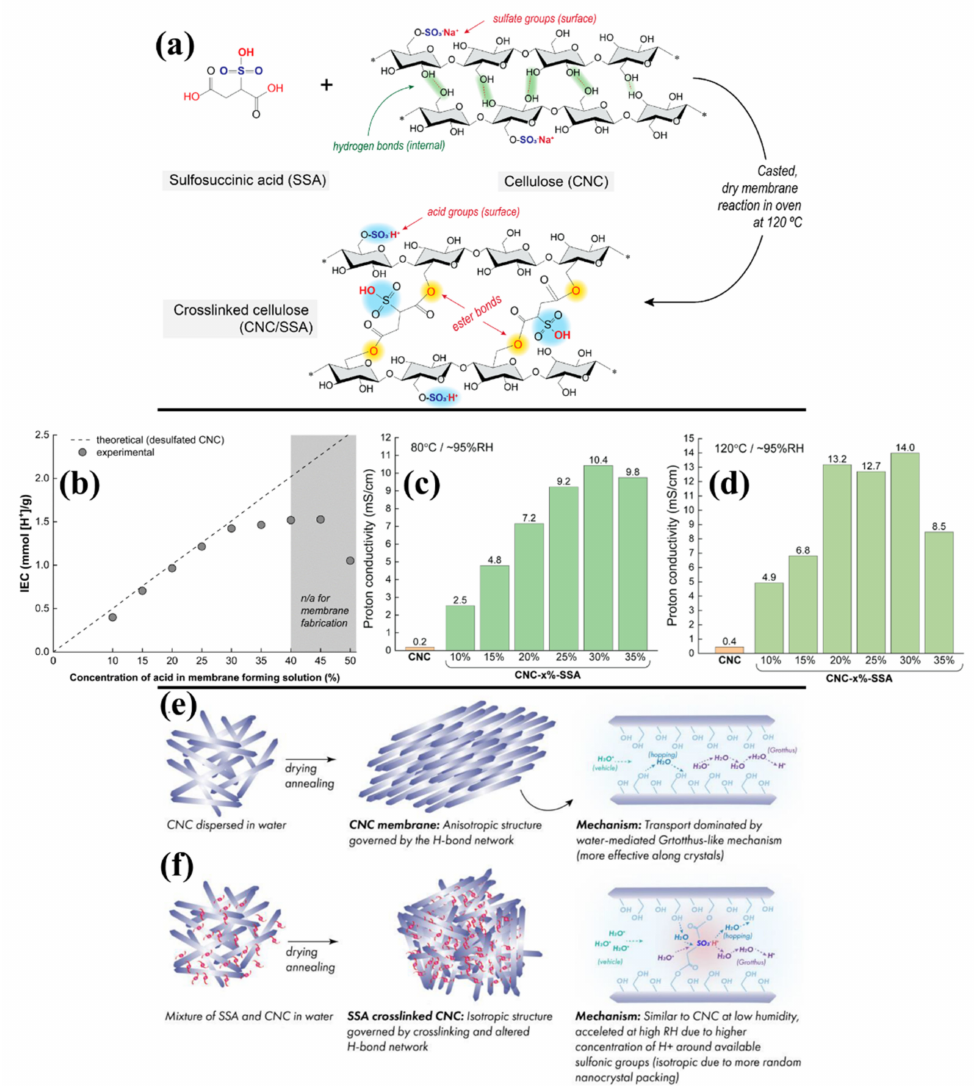
Figure 4. ( a ) An illustration of the cross-linking reaction between sulfosuccinic acid and CNCs, and ( b ) IEC of the CNC − SSA (with different concentrations). Proton conductivity measurement results of different ratios of CNC − SSA membranes ( c ) 80 ◦ C and ( d ) 120 ◦ C. Mechanisms governing membrane development and proton conduction in ( e ) CNC and ( f ) cross-linked CNC